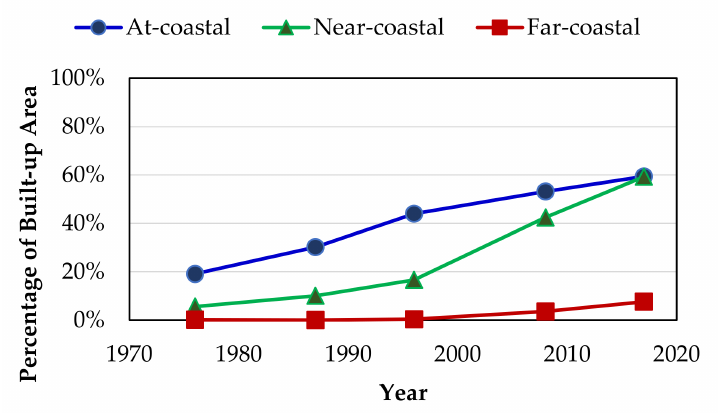
Figure 5. Percentage of Built-up Areas with Respect to